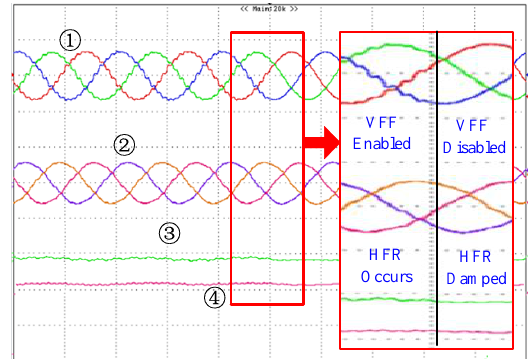
Figure 18. HFR damping for the VSC system with different parameters.